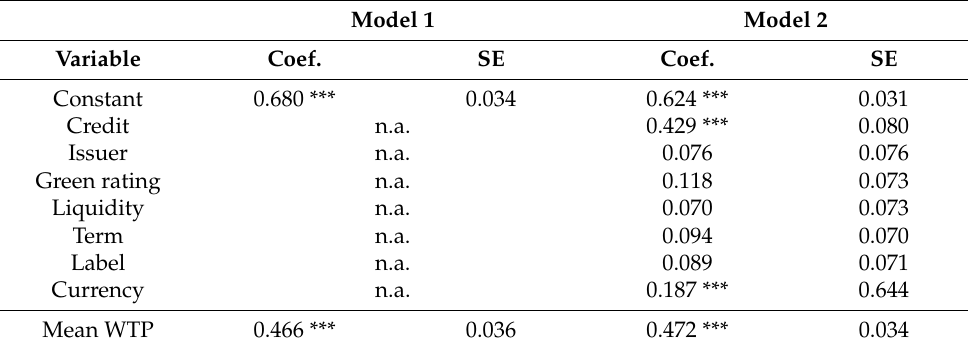
Table 7. Maximum likelihood estimation and mean WTP.